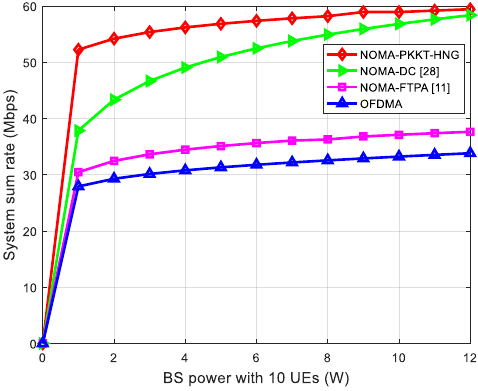
Figure 3. System sum rate vs. base station (BS) power with 10 UEs.